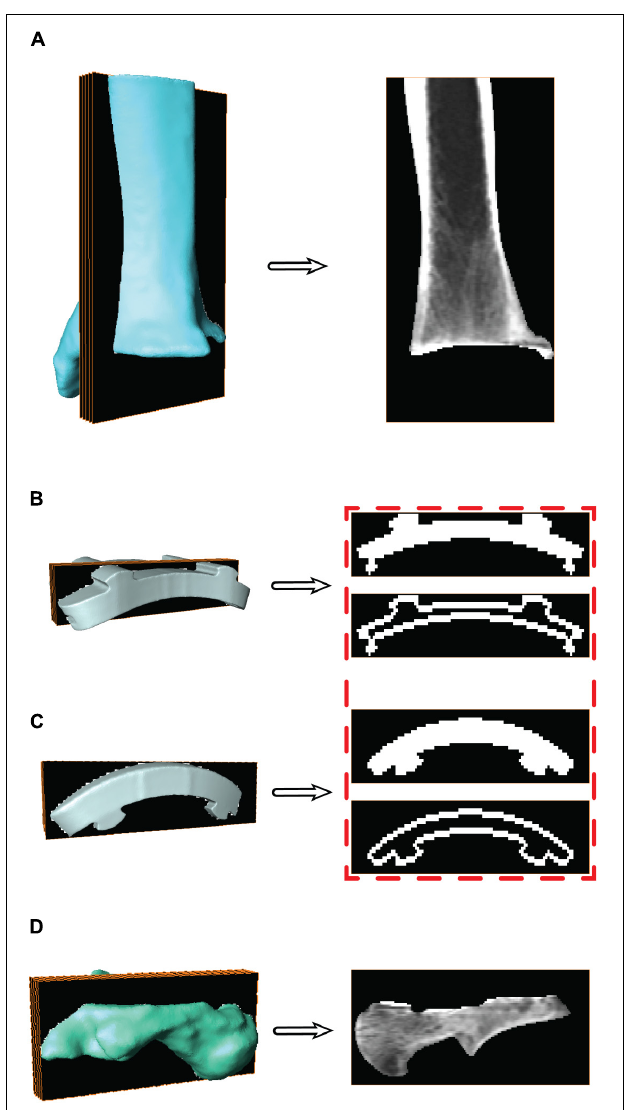
FIGURE 4 | Surface models with a representative sagittal slice show the isolated digitally reconstructed radiographs (DRRs) for the (A) tibia, (B) tibial component, (C) talar component, and (D) talus. Red box highlights the additional step to hollow the implants for improved edge contrast to control for oversaturation during model based tracking